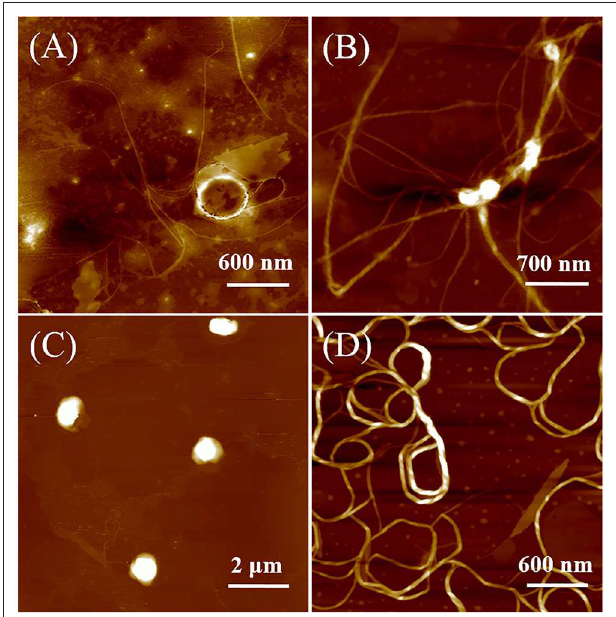
FIGURE 4 | AFM images of DUO-TDI films casted from solutions with varied Vw. (A) Vw = 0 v%, (B) Vw = 25 v%, (C) Vw = 50v %, and (D) Vw = 75 v%. The concentration of all mixed solutions was 5.4 × 10 − 6 M.